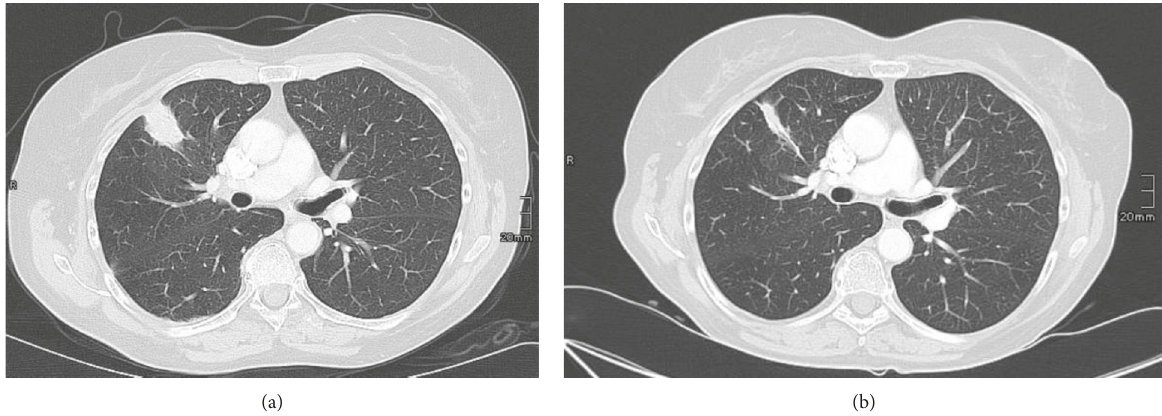
Figure 1: Chest computed tomography scans. (a) The initial scan shows a solid nodular lesion with irregular margins and adjacent to the visceral pleura in the right lower part of the upper lobe. (b) Five years later, the CT scan revealed only a small scar in the former